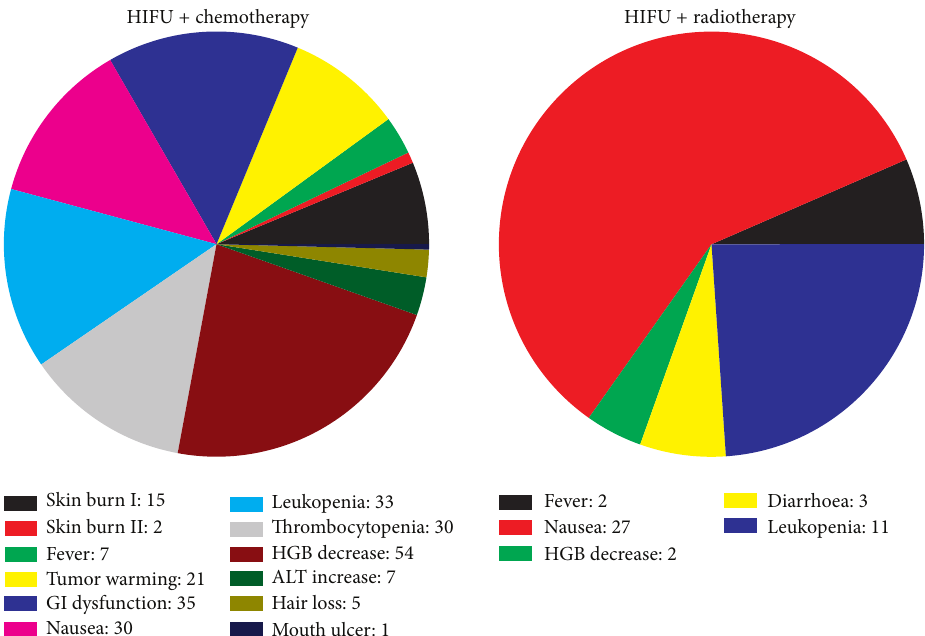
Figure 10: Summary of the complications found in the combination of HIFU ablation with chemotherapy and radiotherapy for advanced pancreatic cancer.